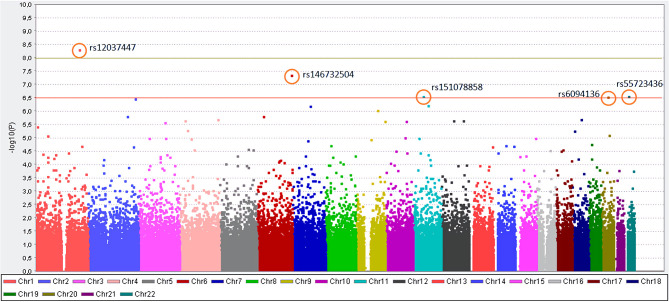
Manhattan plot for the genome-wide association study of patients with KD. The y-axis shows the- log10 of the unadjusted p-values (without Bonferroni correction). On the x-axis, each color represents different chromosomes, and the dots represent SNPs. The red line indicates the association threshold (10−6.5), which represents the corrected p-value = 0.05, while the green line indicates GWAS significant threshold (10−8).